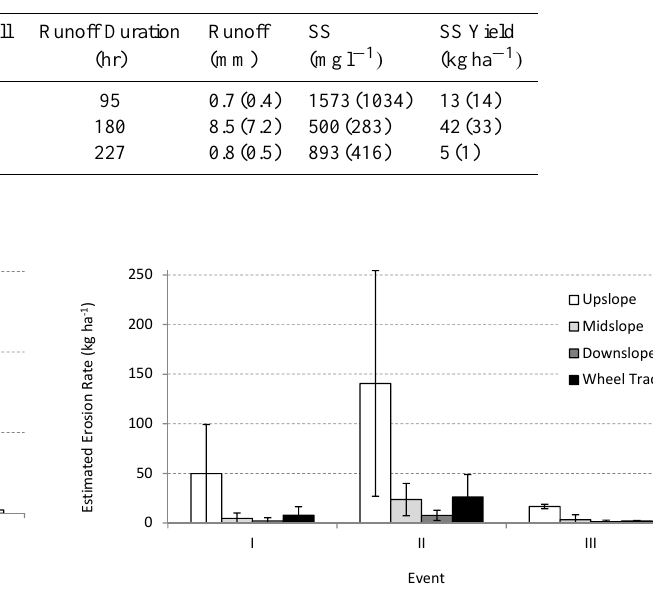
Fig. 2. Depletion rates of applied rare earth tracers for three events monitored at Loddington between January and April 2008 after tag- ging of four hillslope areas. Values are averages for four hillslope lengths, error bars are standard deviations.